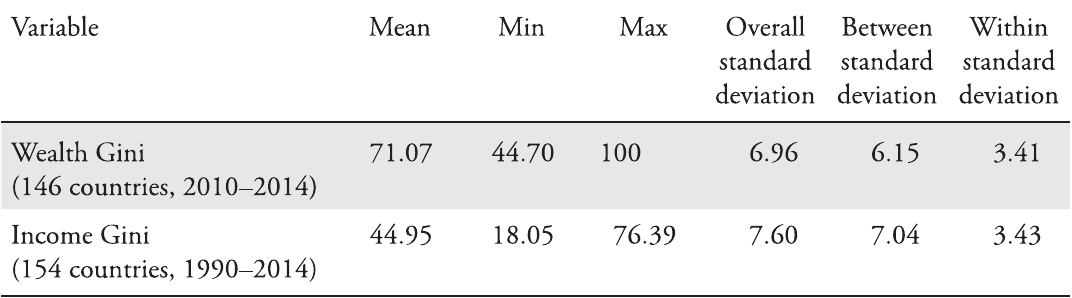
standard standard standard deviation deviation deviation